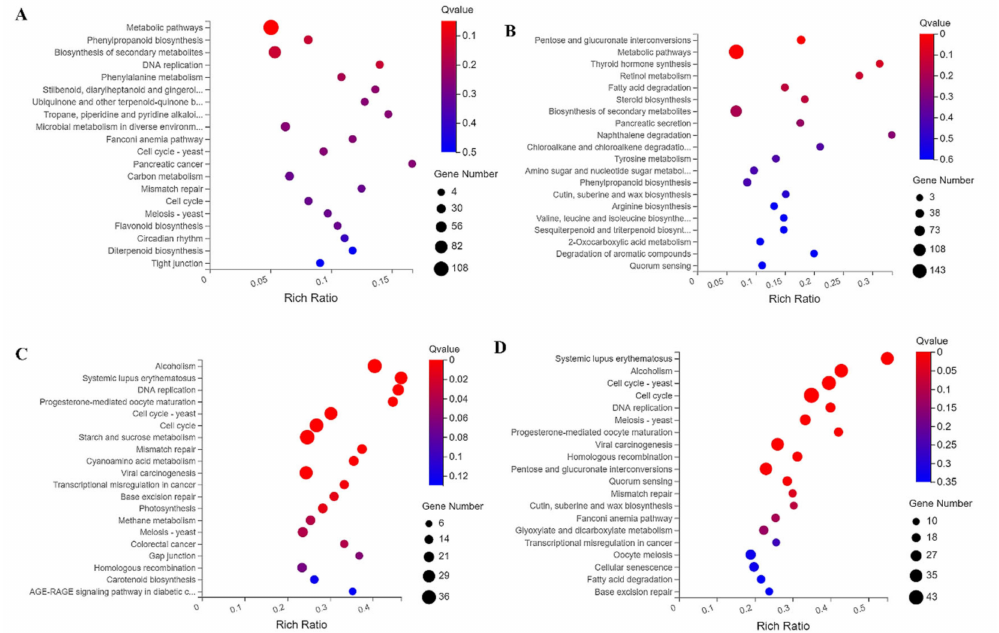
Figure 5. Bubble diagram of KEGG pathway enrichment. ( A ) Enrichment of DEG KEGG pathways in the MM_E vs. CI_E comparison. ( B ) Enrichment of DEG KEGG pathways in the MM_M vs. CI_M comparison. ( C ) Enrichment of DEG KEGG pathways in the MM_E vs. MM_M comparison. ( D ) Enrichment of KEGG pathways of DEGs in the CI_E vs. CI_M comparison. The sizes of the bubbles indicate the numbers of genes enriched in the KEGG pathways, where the larger the bubble is, the greater the number of genes, and the color of the bubble represents the Q